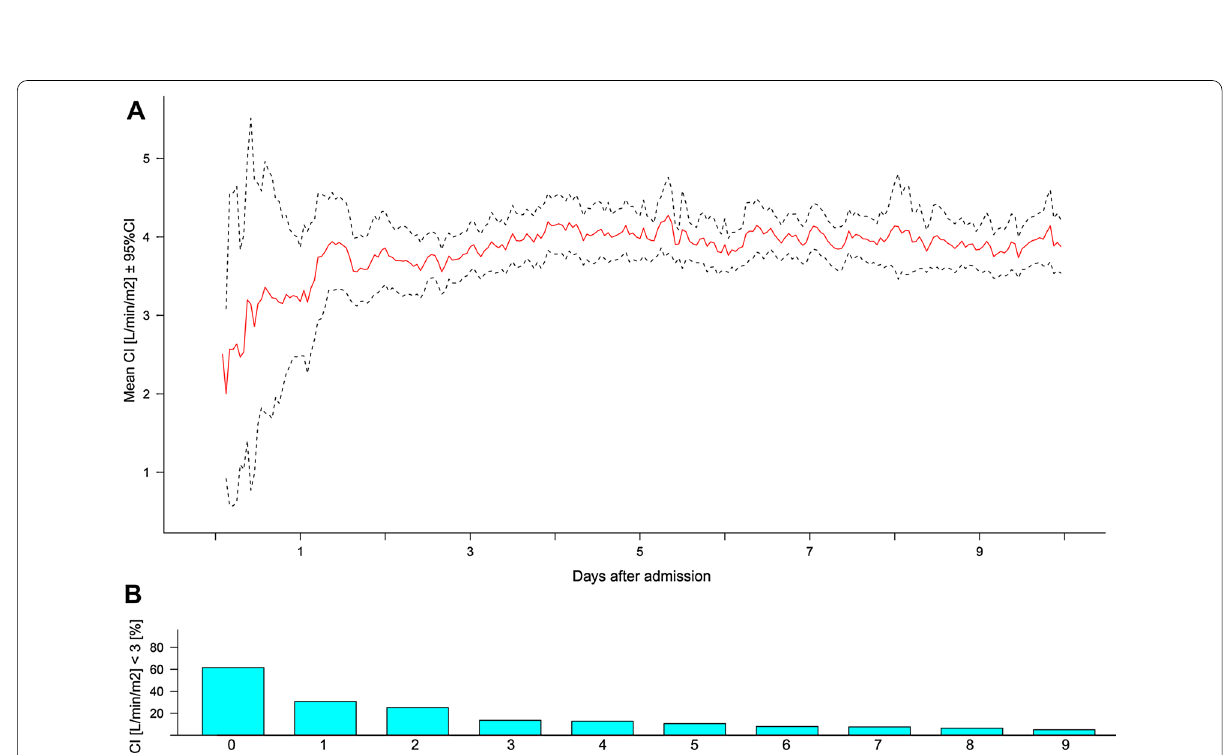
Fig. 2 A Mean CI values and ( B ) daily percentage of CI < 3 L/min/m 2 over the study time of 10